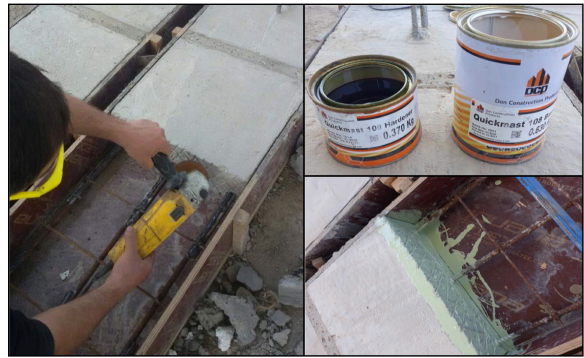
Figure 8: Preparing old concrete surface.